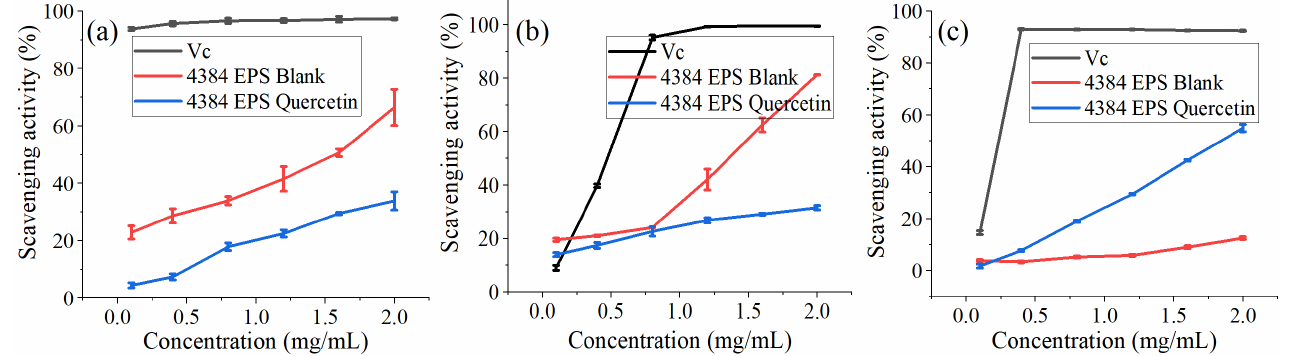
Figure 6. ( a ) Ability of EPS and Q-EMP to scavenge DPPH (2,2-diphenyl-1- picrylhydrazyl) free radicals. ( b ) Ability of EPS and Q-EMP to scavenge OH free radicals. ( c ) Ability of EPS and Q-EMP